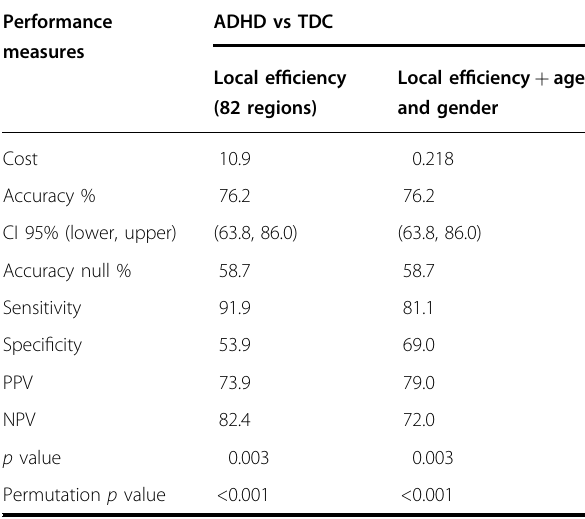
Table 1 Accuracy statistics for support vector machine (SVM) classi fi er models predicting diagnostic group (ADHD vs TDC), using leave-one-out